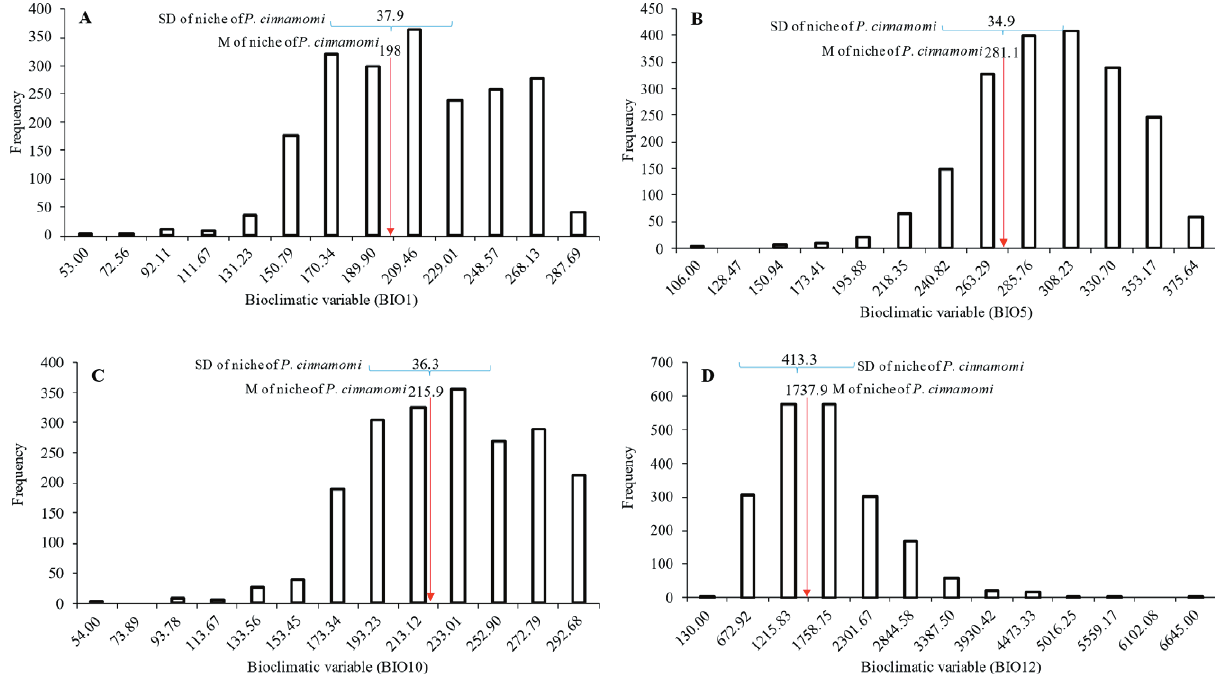
Figure 2. Relationship between coincident bioclimatic variables of the ecological niche models of Persea americana and Phytophthora cin- namomi from Persea Americana . A: BIO 1: Annual Mean Temperature. B: BIO 5: Maximum Temperature of Warmest Month. C: BIO 10: Mean Temperature of Warmest Quarter. D: BIO 12: Annual Precipitation. The values on the blue lines represent the standard deviations (SD), and the red down arrows represent the median (M) of the variables obtained for the niche of Phytophthora cinnamomi obtained records from Persea americana. Black bars represent the frequency values of the variables for the niche of P. americana under Americas. All variable values were obtained from 100 random combinations of occurrence ( Phytophthora cinnamomi and Persea americana ) and extracted from the niche of Phytophthora cinnamomi and Persea americana under Americas